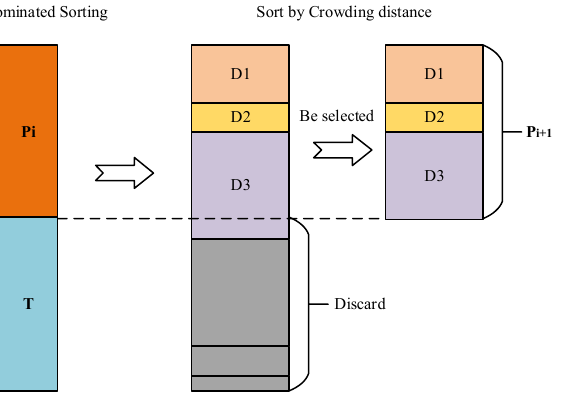
Figure 4. Non-dominated sorting in NSGA-II, where Pi is the parent population while T is the result population after crossover and mutation. P i+1 represents the result after non-dominated sorting.